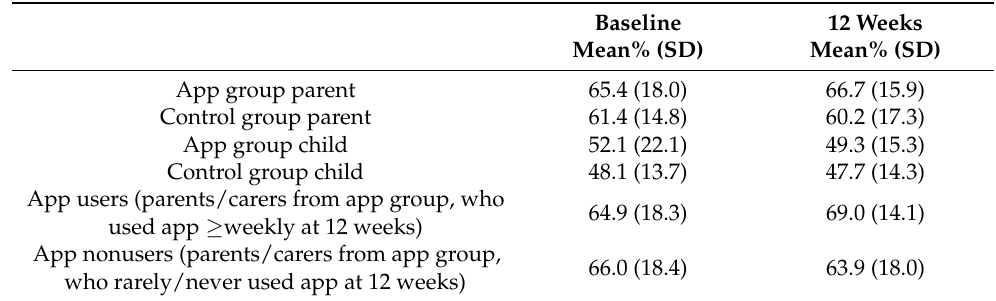
Table 6. Mean percentage of correct answers on protein-labelling knowledge/interpretation ques- tionnaire, by all